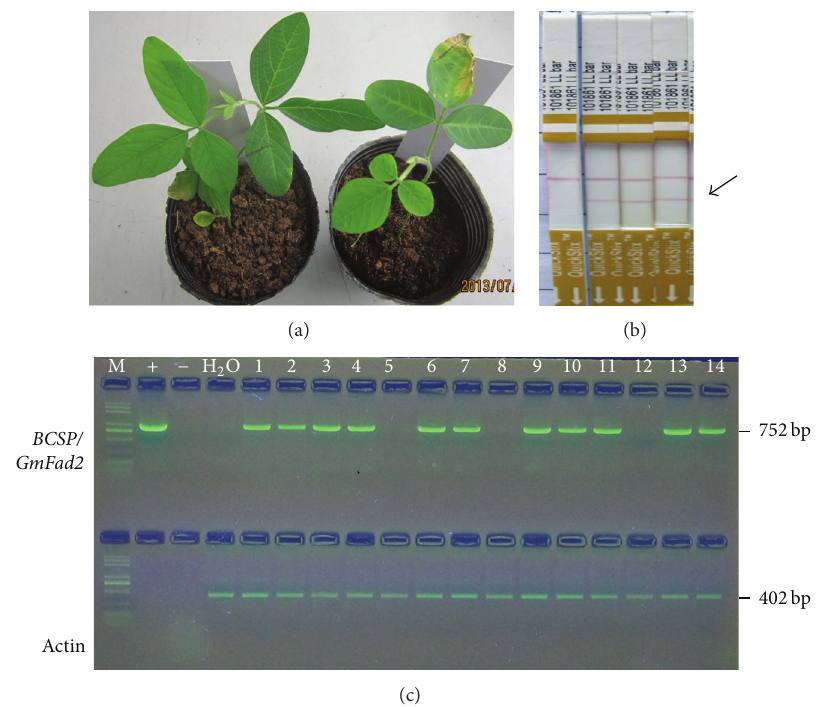
Figure 3: Procedure for confirmation of transgenic plants. (a) Identification of the herbicide resistance of the leaves of transgenic soybean plants using 135mg/L Basta. Left: negative transgenic plant; right: positive transgenic plants. (b) Events of the PCR positive lines were randomly selected and tested using LibertyLink strips. (c) PCR analysis of genome DNA of putative transgenic soybean plant. The length of PCR production was 752 bp. M: trans2K plus DNA marker; +: plasmid DNA; − : nontransformed soybean; H 2 O. 1–14: the transgene line.